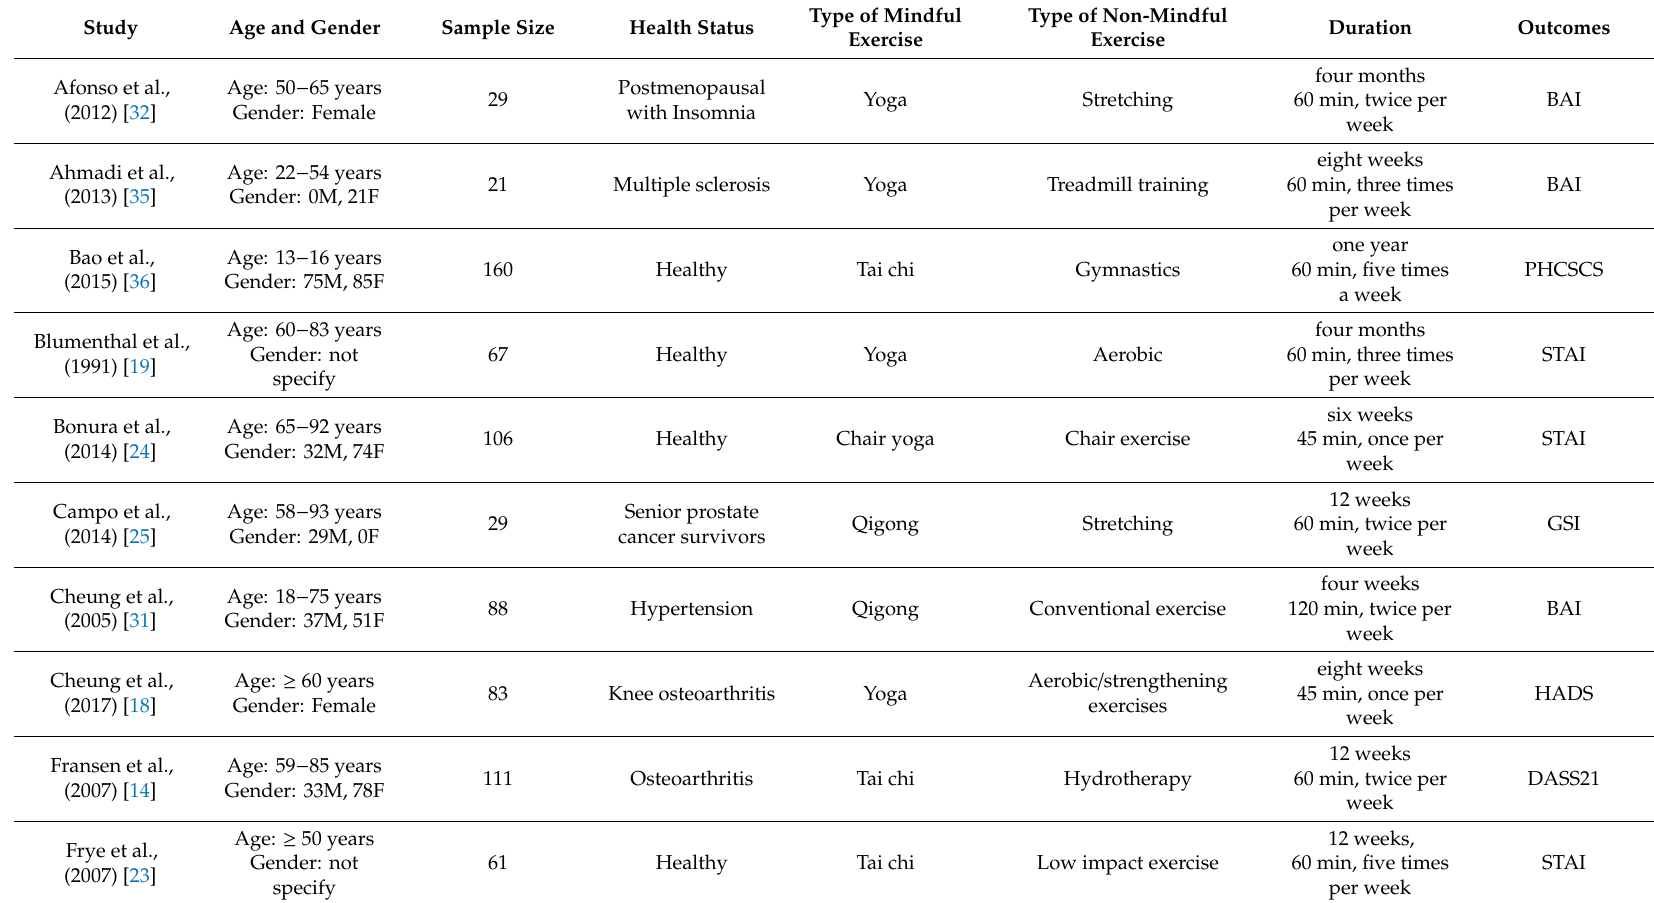
Table 1. Summary of the included